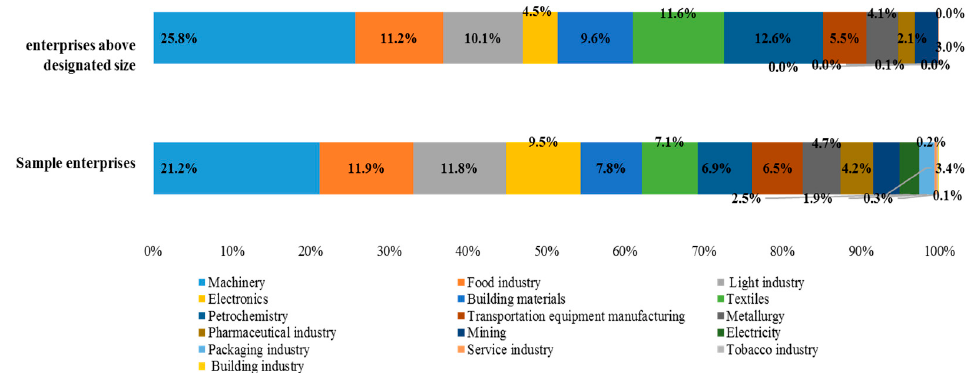
Figure 5. Sector representativeness of sample enterprises.